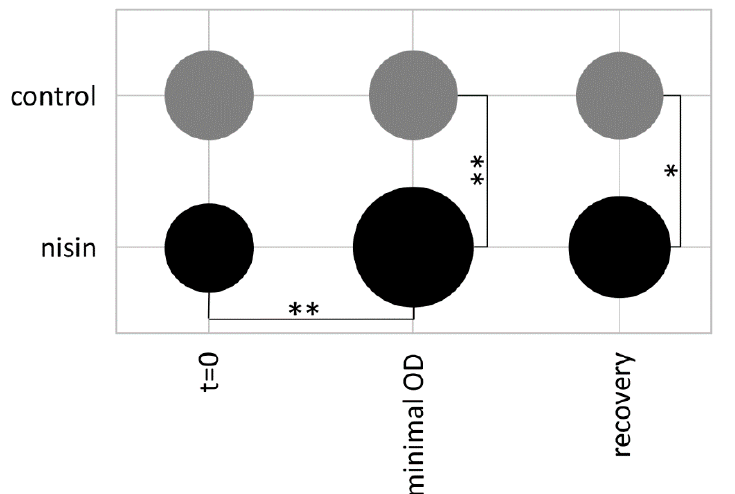
Figure 8. Number of flagella per cell of C. difficile 630 ∆ erm during adaptation to nisin. The number of flagella was obtained from transmission electron micrographs and the average value for at least ten bacterial cells was used in this diagram (see Supplemental Figure S2 for representative images). Nisin was added to the cells displayed in line “nisin” whereas those displayed in line “control” were not treated. Samples were taken at the timepoint of nisin addition to the nisin culture (t = 0), when the culture reached the lowest OD (minimal OD) and during the phase of growth recovery (recovery) (see Figure 1 for a representative growth curve). Student’s t -tests were performed for every comparison along horizontal lines for “control” and “nisin” conditions to analyze statistical significance along the time series. Additional t -tests along vertical lines were performed to analyze statistical significance between “control” and “nisin” conditions at every timepoint. (*) indicates a p -value < 0.05, (**) indicates a p -value < 0.001.